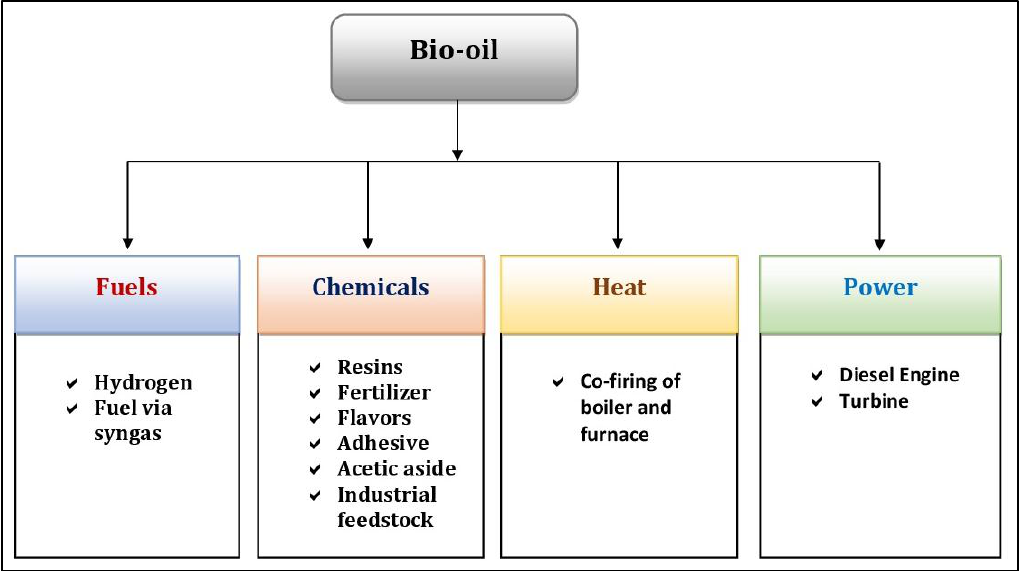
Figure 5. Various applications of pyrolysis bio-oil [77,78].